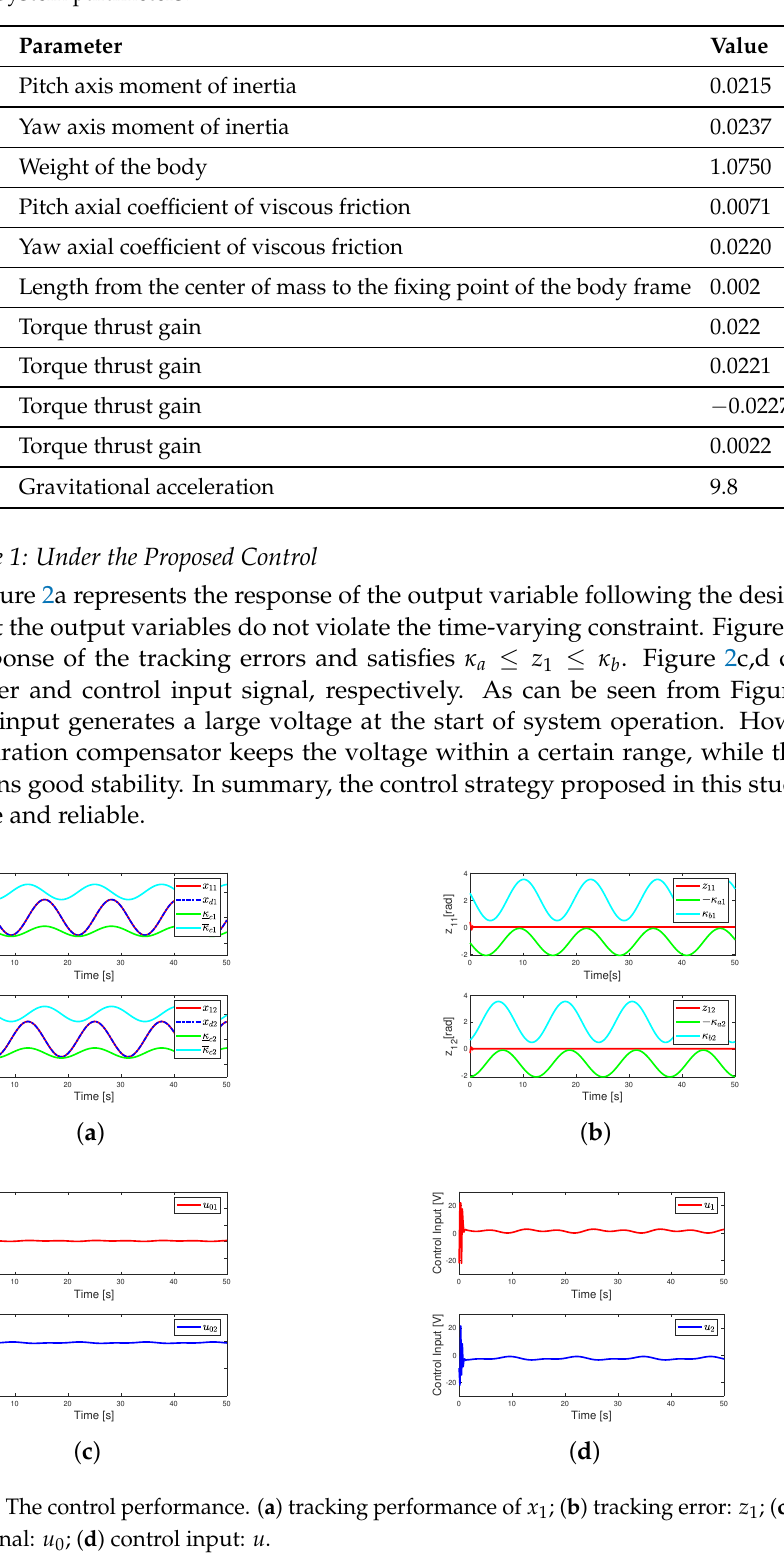
Table 1. System parameters.